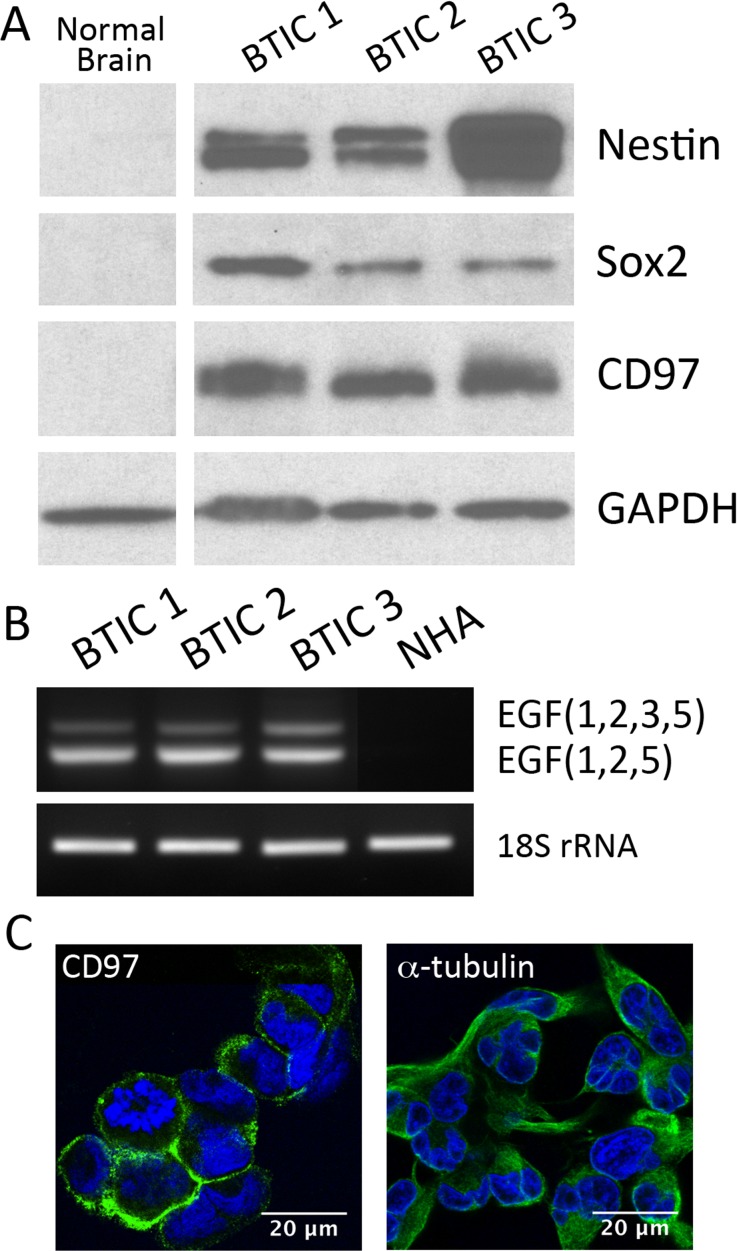
CD97 expression in glioblastoma-derived brain tumor initiating cells.Brain tumor initiating cell lines were derived from three patients with histologically confirmed GBM. These cell lines were found to express the stem cell markers nestin and Sox2, as well as CD97, while normal human brain expressed none of these (A). PCR analysis of these cell lines found them to express the EGF(1,2,5) and EGF(1,2,3,5) isoforms of CD97 as confirmed by sequencing analysis (B). Immunocytochemistry demonstrated localization of CD97 to the cell membrane in BTIC cell line 3 (C).